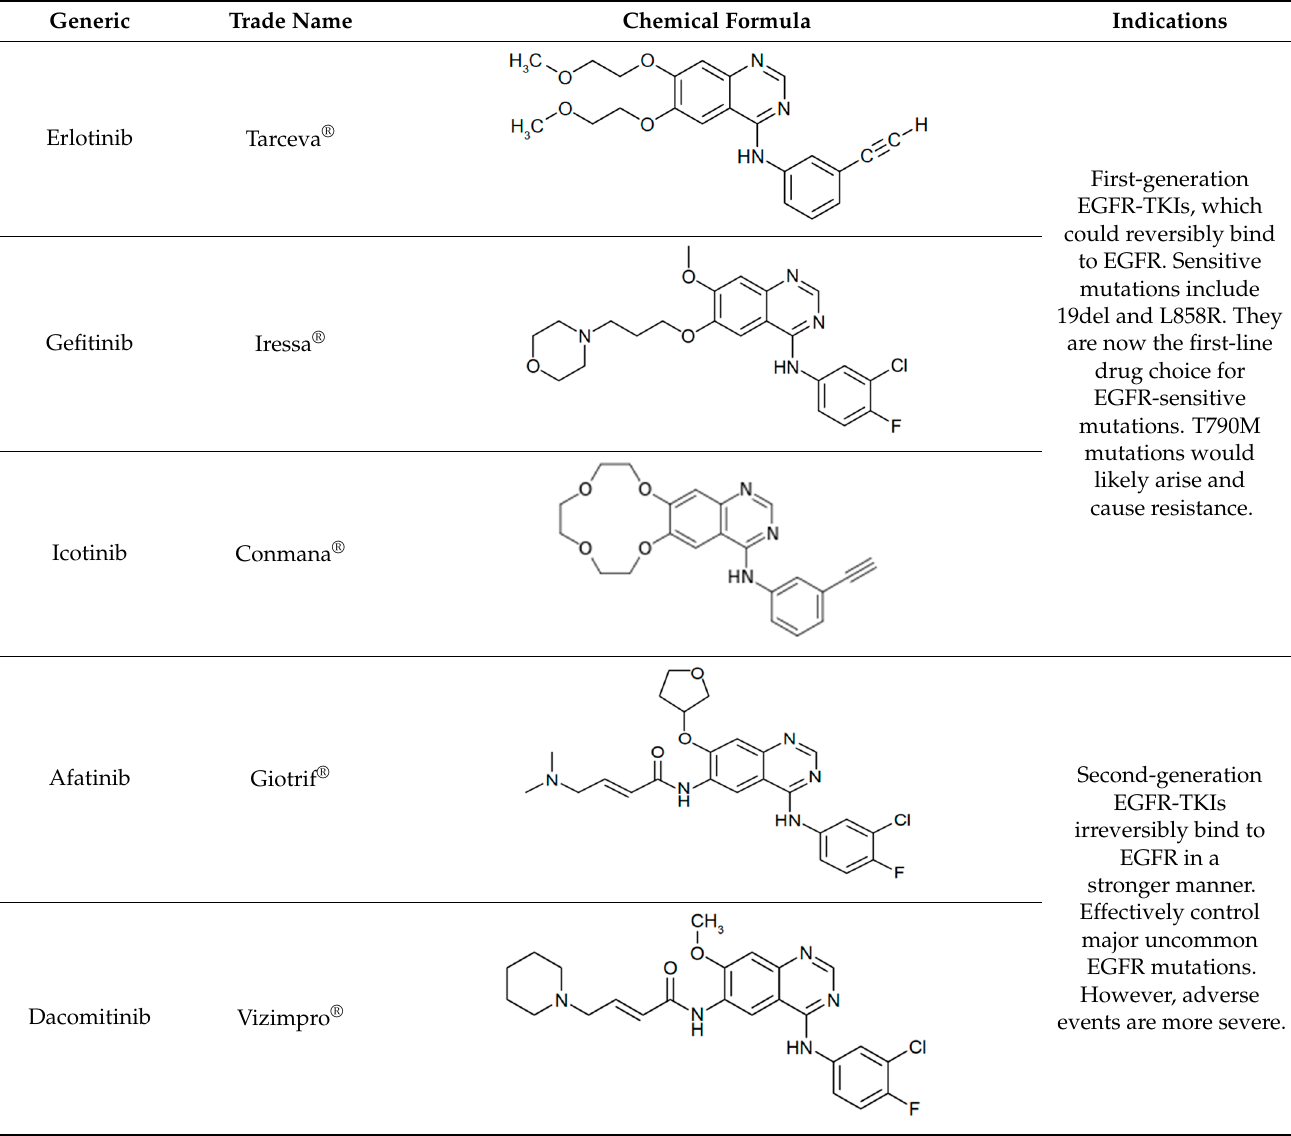
Table 1. Overview of three generations of EGFR-TKIs and their indications.